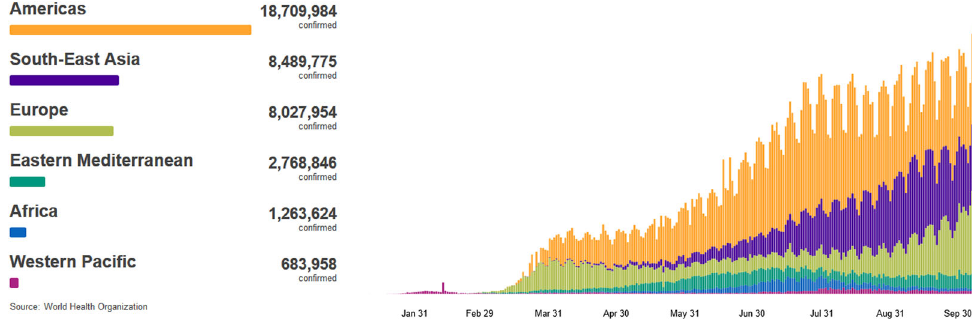
Fig. 5 WHO regions wise case comparison from 11 January to 19 October 2020. Open Source: